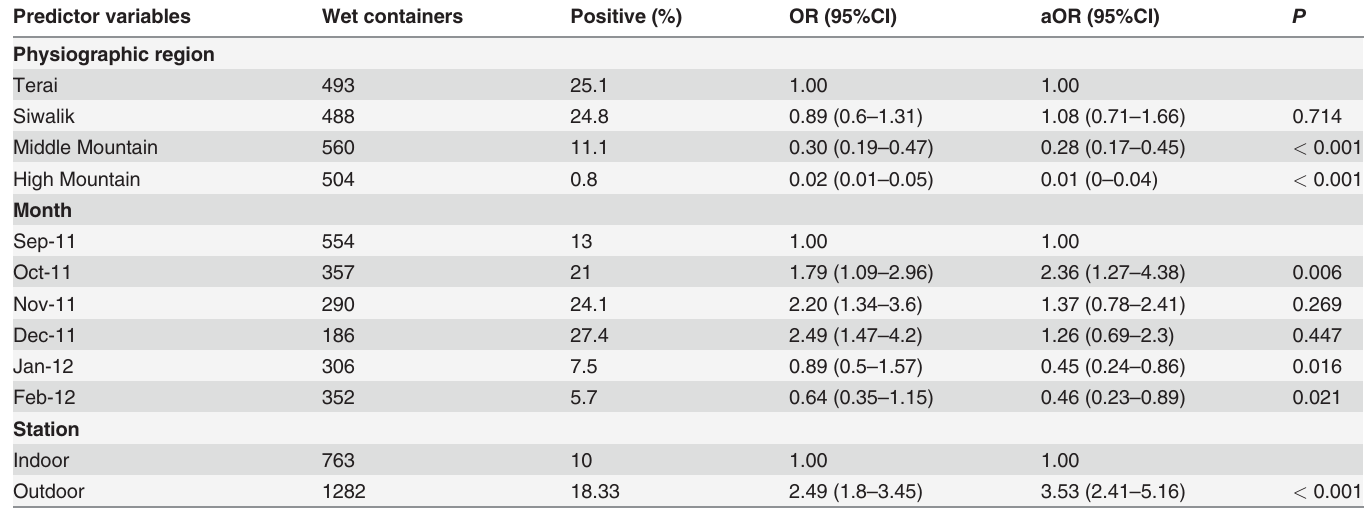
Table 3. Multivariate logistic regression analysis for the presence of Aedes aegypti larvae and pupae. Predictor variables